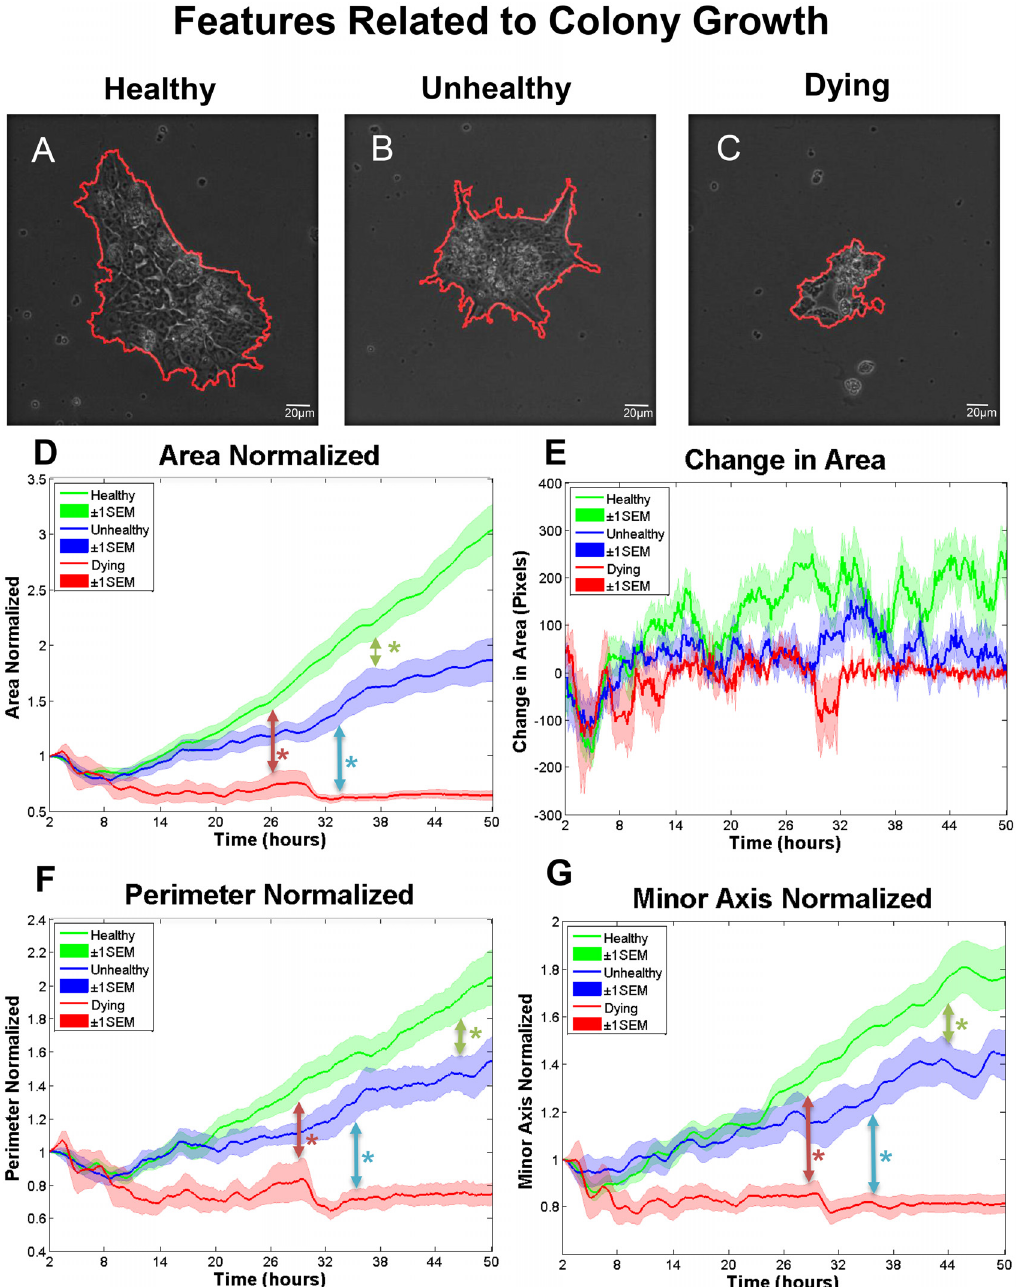
Fig 1. Features related to hESC colony growth. The outline of segmentation for a healthy (A), unhealthy (B), and a dying colony (C) at the last recorded frame. (D) Area normalized to the first time point for colonies that were healthy, unhealthy, and dying. Colonies first became significantly different by 2-way ANOVA at 37.6 hours for healthy vs unhealthy (green arrow), at 33.5 hours for unhealthy versus dying (blue arrow), and at 26.2 hours for healthy versus dying colonies (red arrow). (E) Change in area over time showing second contraction of dying colonies at 30 – 32 hours. (F) Perimeter over time normalized to the first time point for colonies that were healthy, unhealthy, and dying. Colonies first became significantly different by 2-way ANOVA at 46.6 hours for healthy versus unhealthy groups (green arrow), at 35.4 hours for unhealthy versus dying groups (blue arrow), and at 28.9 hours for healthy versus dying groups (red arrow). (G) Minor axis normalized to the first time point for colonies that were healthy, unhealthy, and dying. Colonies first became significantly different by 2-way ANOVA at 44.3 hour for healthy versus unhealthy groups (green arrow), at 36.5 hour for unhealthy versus dying groups (blue arrow), and at 28.9 hour for healthy versus dying group (red arrow). Number of colonies per group = 16 healthy, 12 unhealthy, 6 dying. Data are plotted as means ± SEM for each group. Arrows indicate first values that differed significantly from the control by 2-way ANOVA ( * = P <